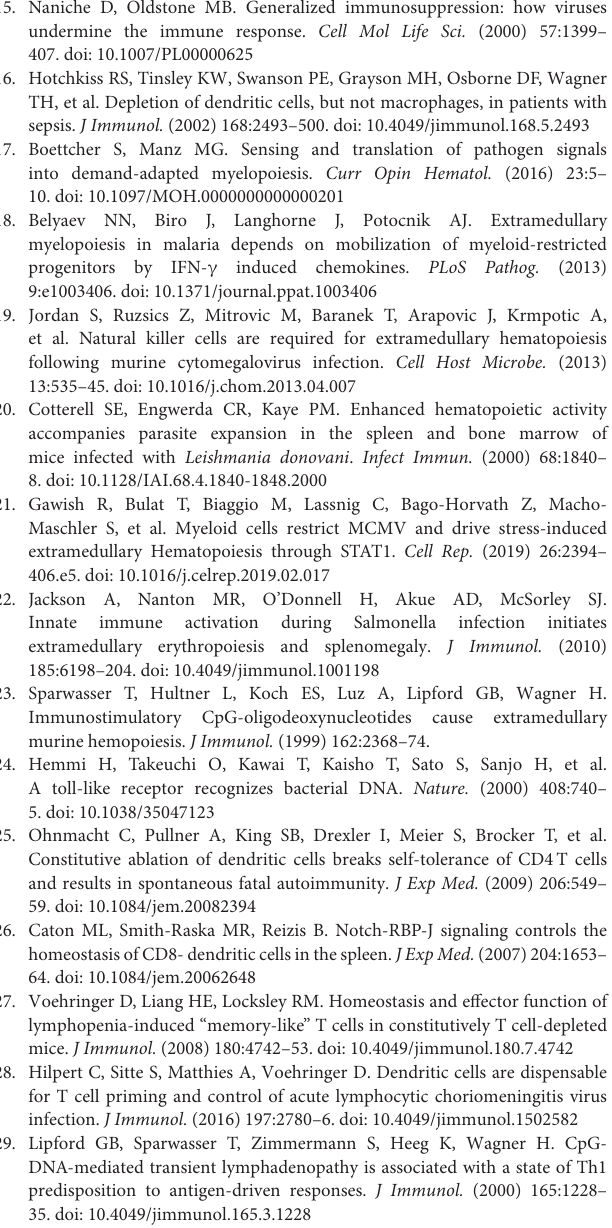
examined by flow cytometry at day 6 post treatment. Dot blots show surface phenotype of CD3 − CD19 − bone marrow cells. Data of the animal representing the median of n = 5 animals are shown.